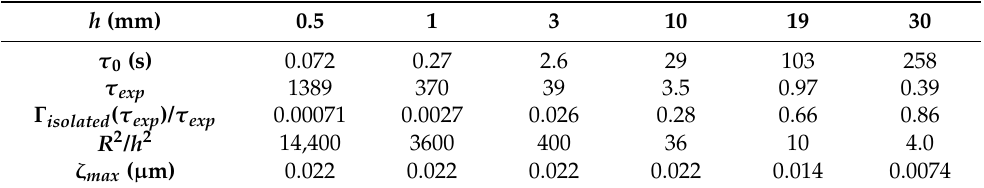
Table 4. Variation of the disc thickness h for float glass, R = 120/2 mm and t exp = 100